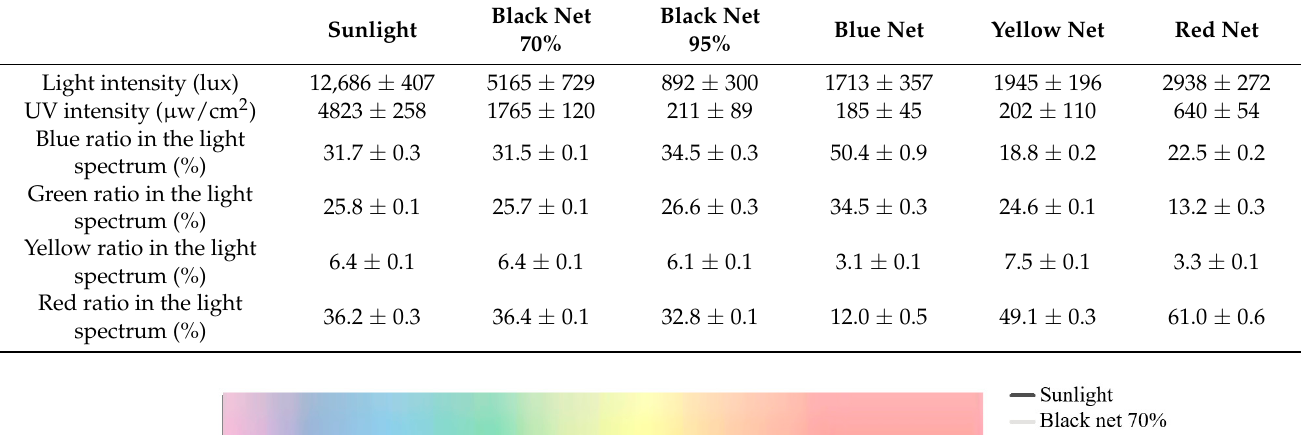
Table 1. The basic light condition parameters under different shade nets. Sunlight